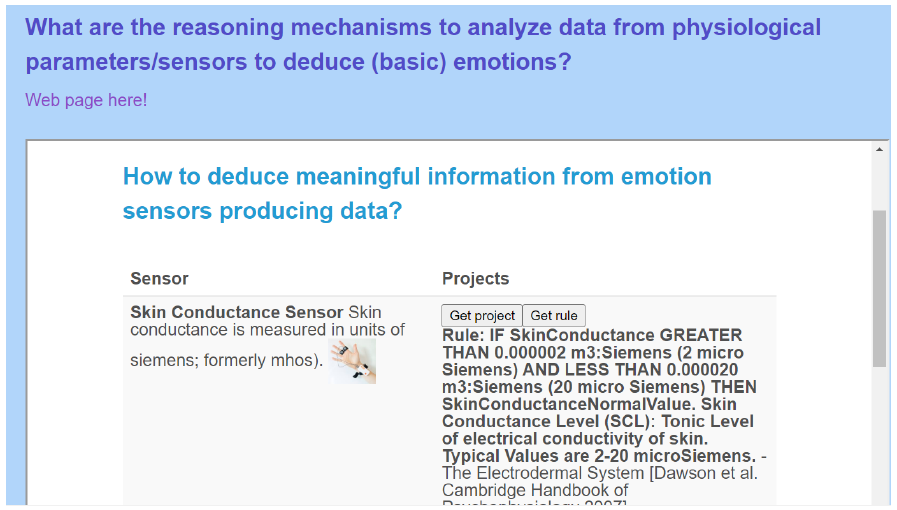
Figure A7. Reasoning mechanisms relevant to analyze emotion data.